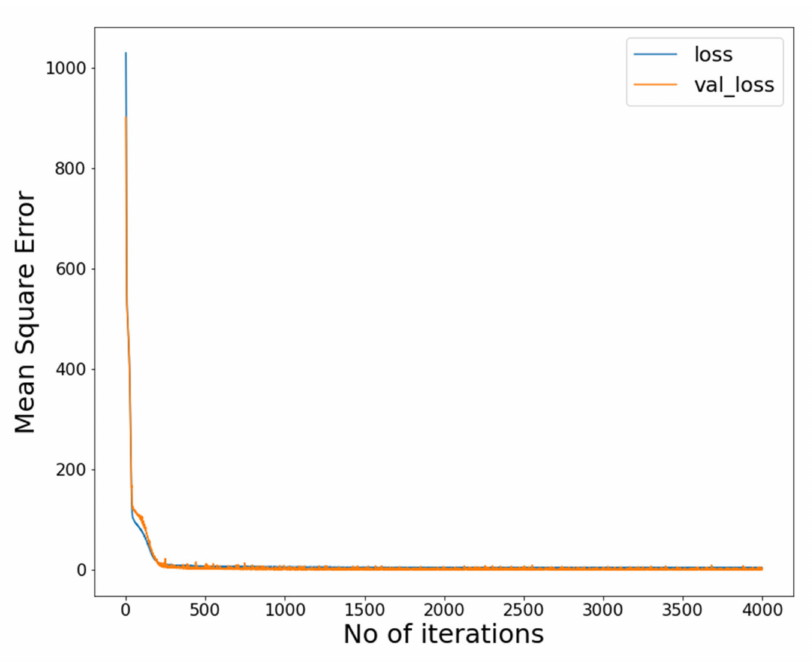
Figure 6. MSE trend.